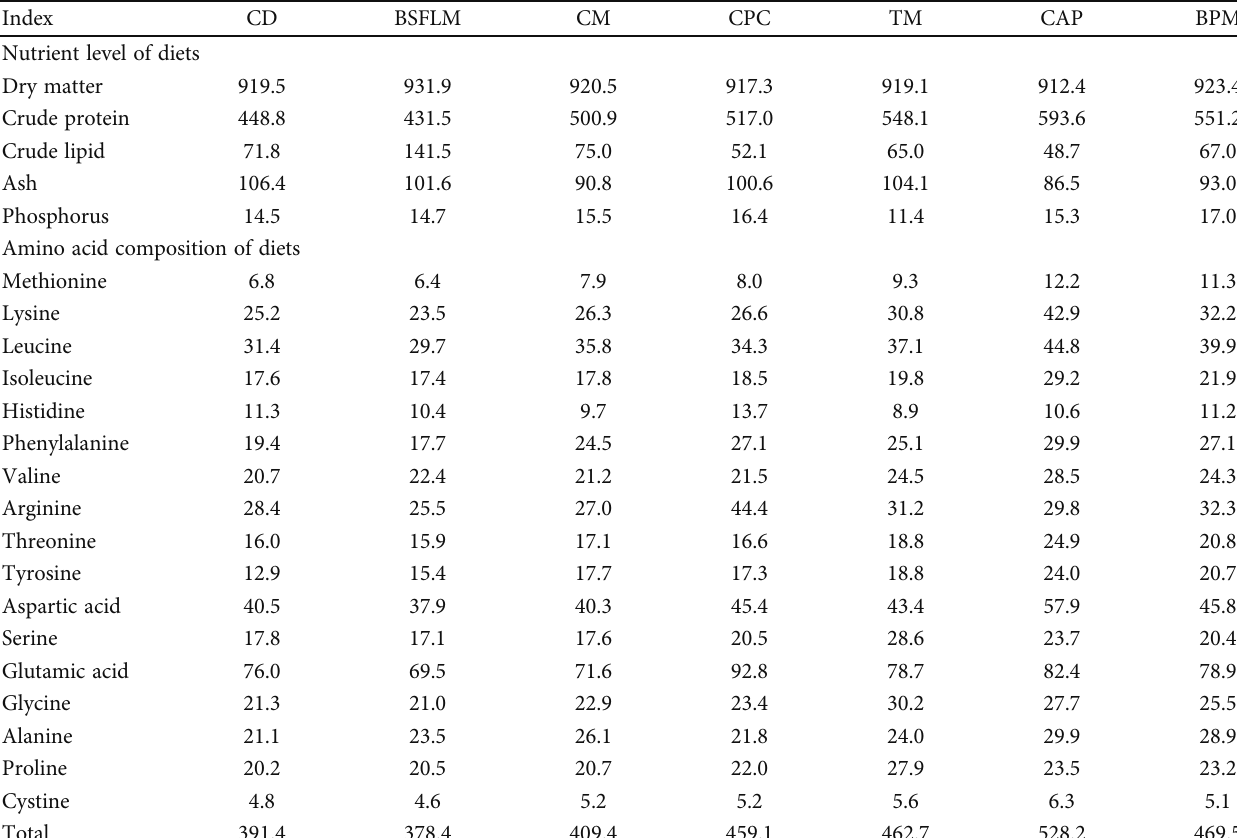
Table 3: Nutrient level and amino acid composition of experimental diets (g/kg dry